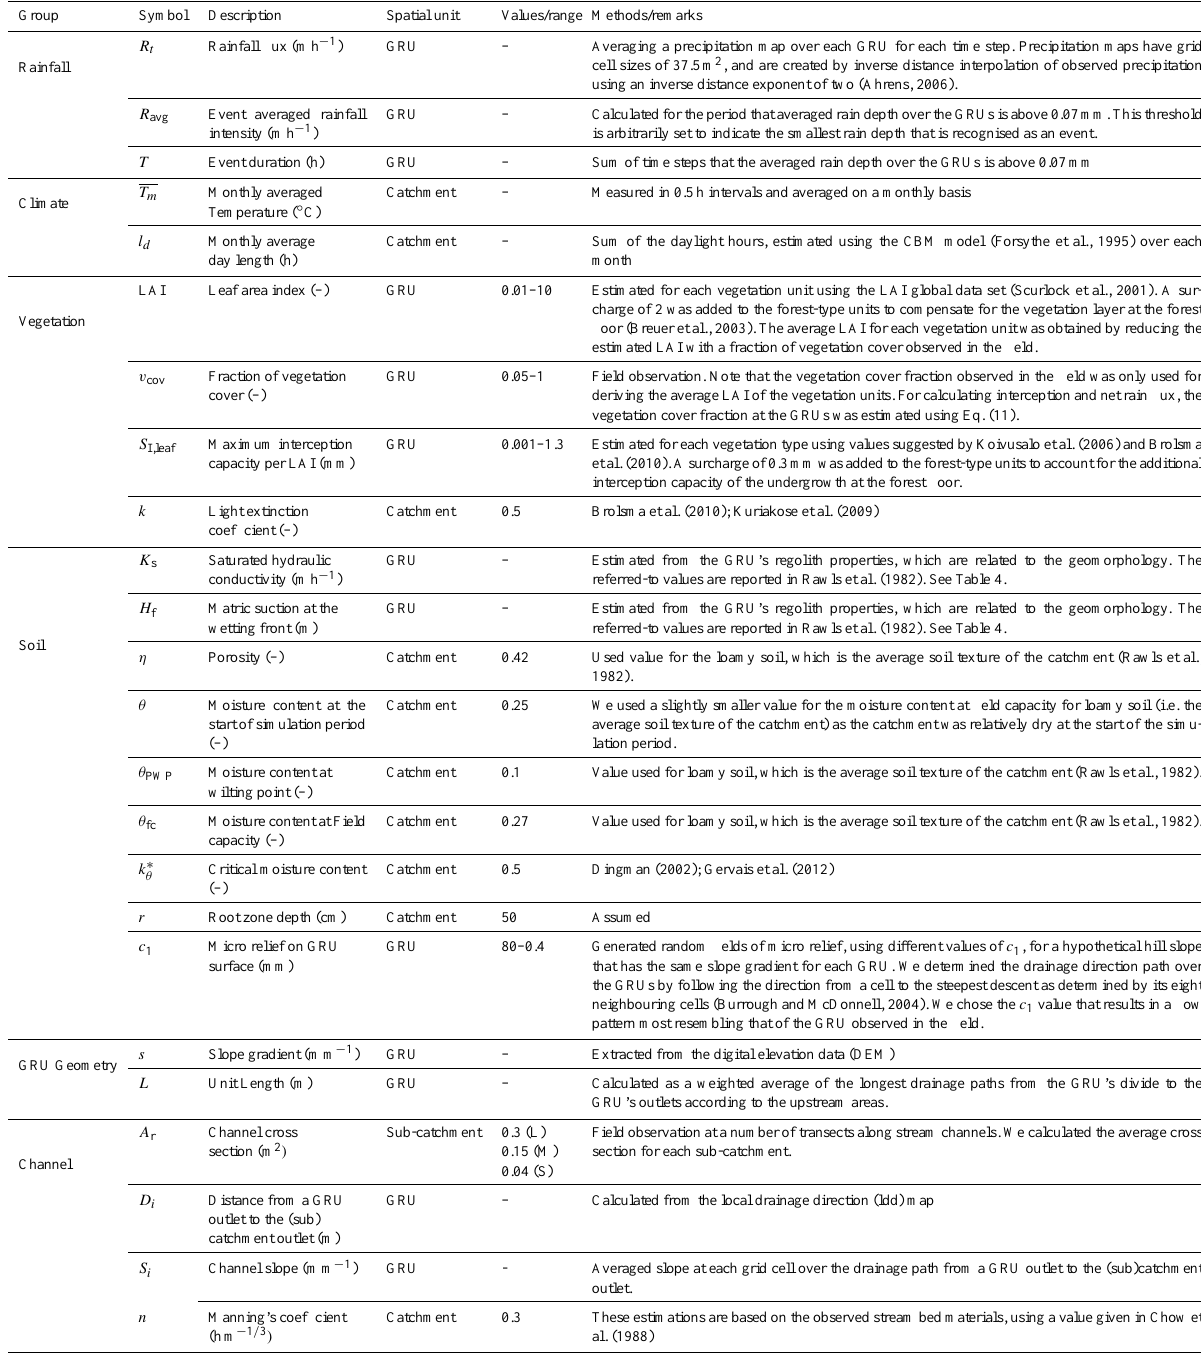
Table 1. Input, parameters, and parameterization method used in the modelling